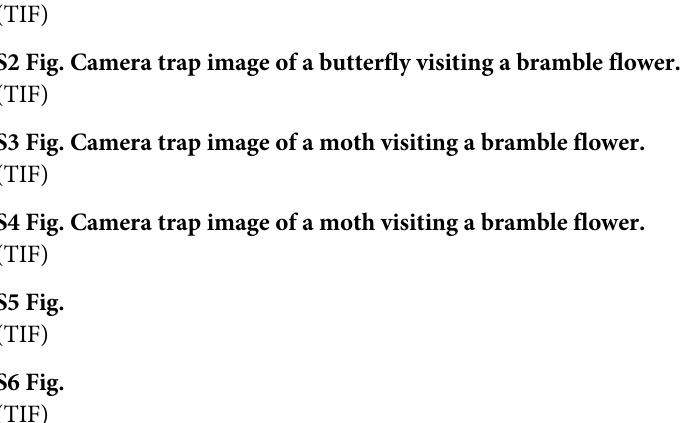
S1 Table. List of sampling dates for each of the 10 study sites with mean daily and nightly temperatures and rainfall. S2 Table. List of sunrise and sunset times for the sampling